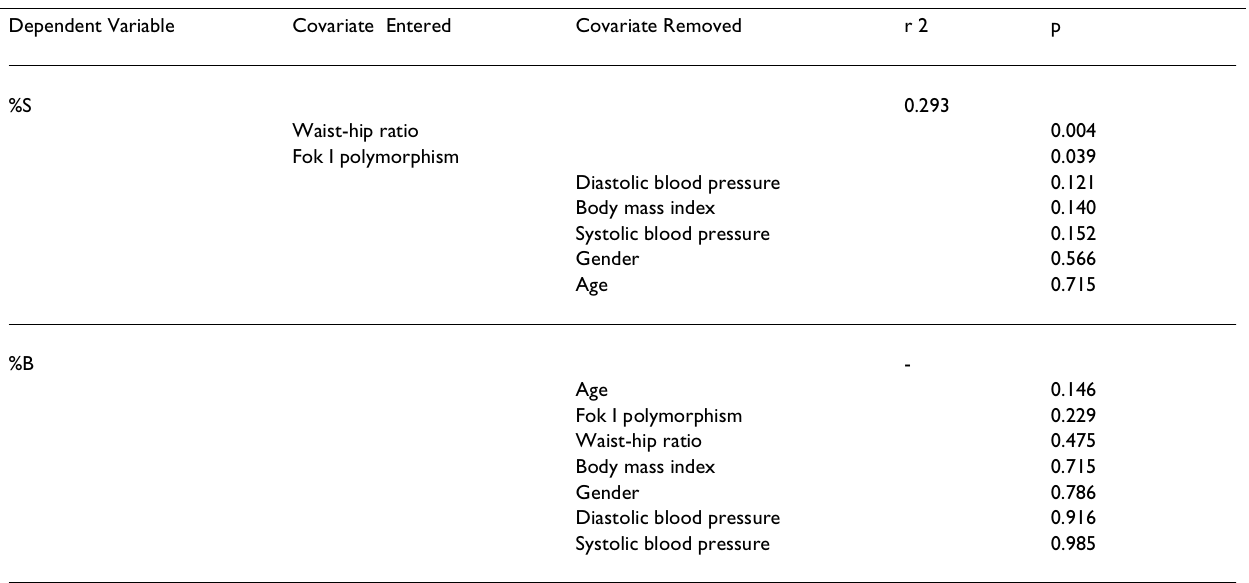
Table 2: Stepwise regression analysis Dependent Variable Covariate Entered Covariate